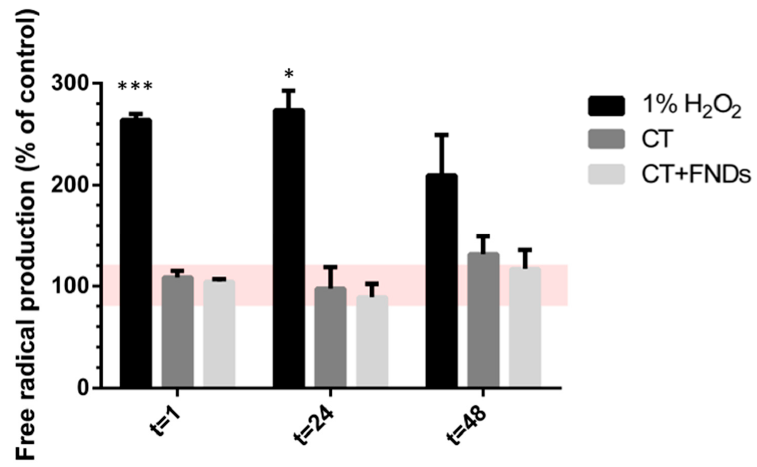
Figure 6. Total free radical production (measured by conversion of DCFDA to DCF). Yeast cells without a stimulant were used as a negative control to relate all values to. Values represent averages out of three biologically independent experiments, each performed in quadruplicate. Error bars represent standard errors of the mean. Significance was tested against the control (* p ≤ 0.05, *** p ≤ 0.001).